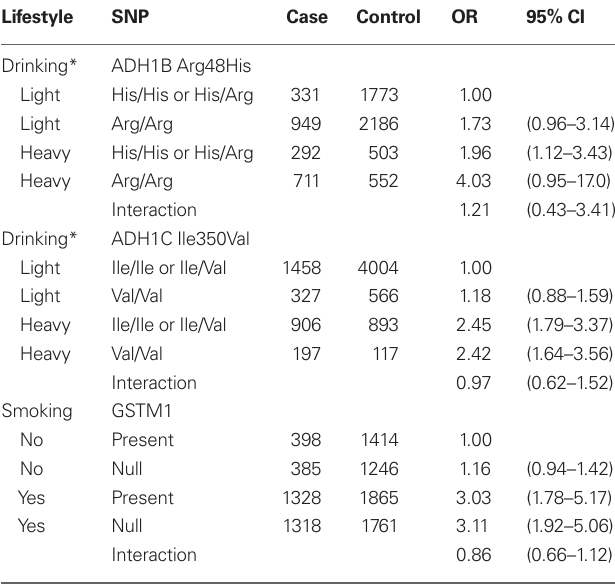
Table 6 | Joint effects of drinking and ADH1B Arg48His and ADH1C Ile350Val and smoking and gSTM1 on the risk of head and neck